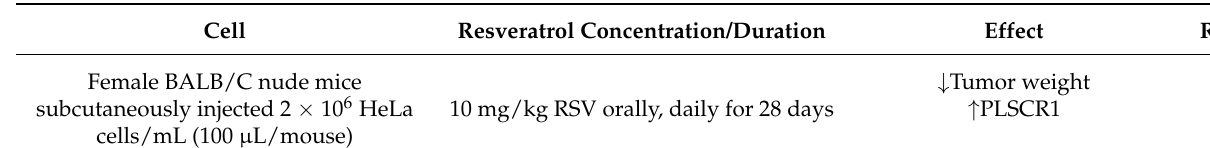
Table 3. Effects of Resveratrol against Cervical Cancer: in vivo animal